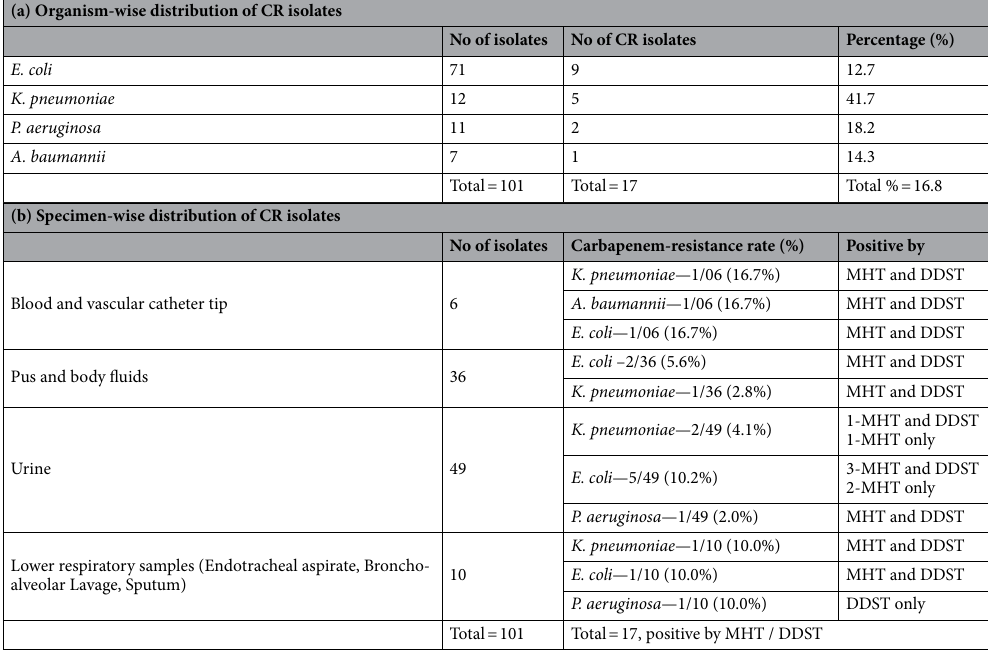
Table 1. Distribution and phenotypic carbapenem-resistance rate of isolated Gram-negative bacteria using MHT and DDST methods. * DDST double disc synergy test, MHT modified hodge